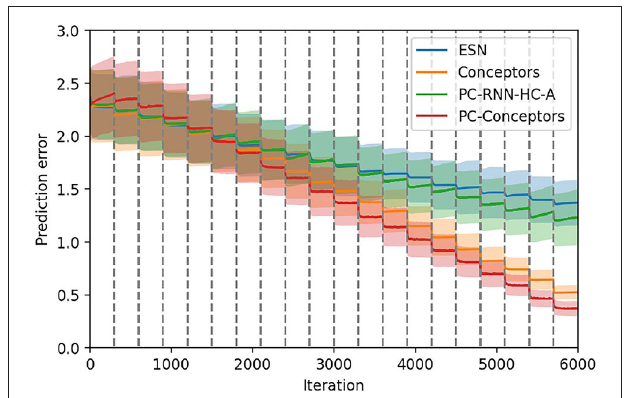
FIGURE 11 | Comparison between the ESN, the Conceptors model, the PC-RNN-HC-A model, and the PC-Conceptors model on the first test set. The 20 tasks are delimited by the dashed gray